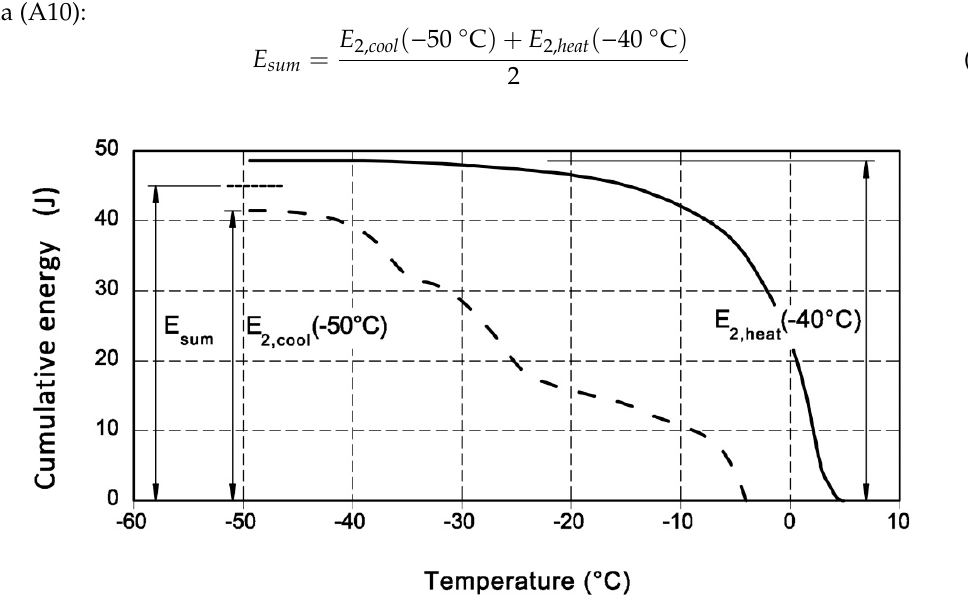
Figure A3. Schematic of determination of the total amount of phase transition energy.